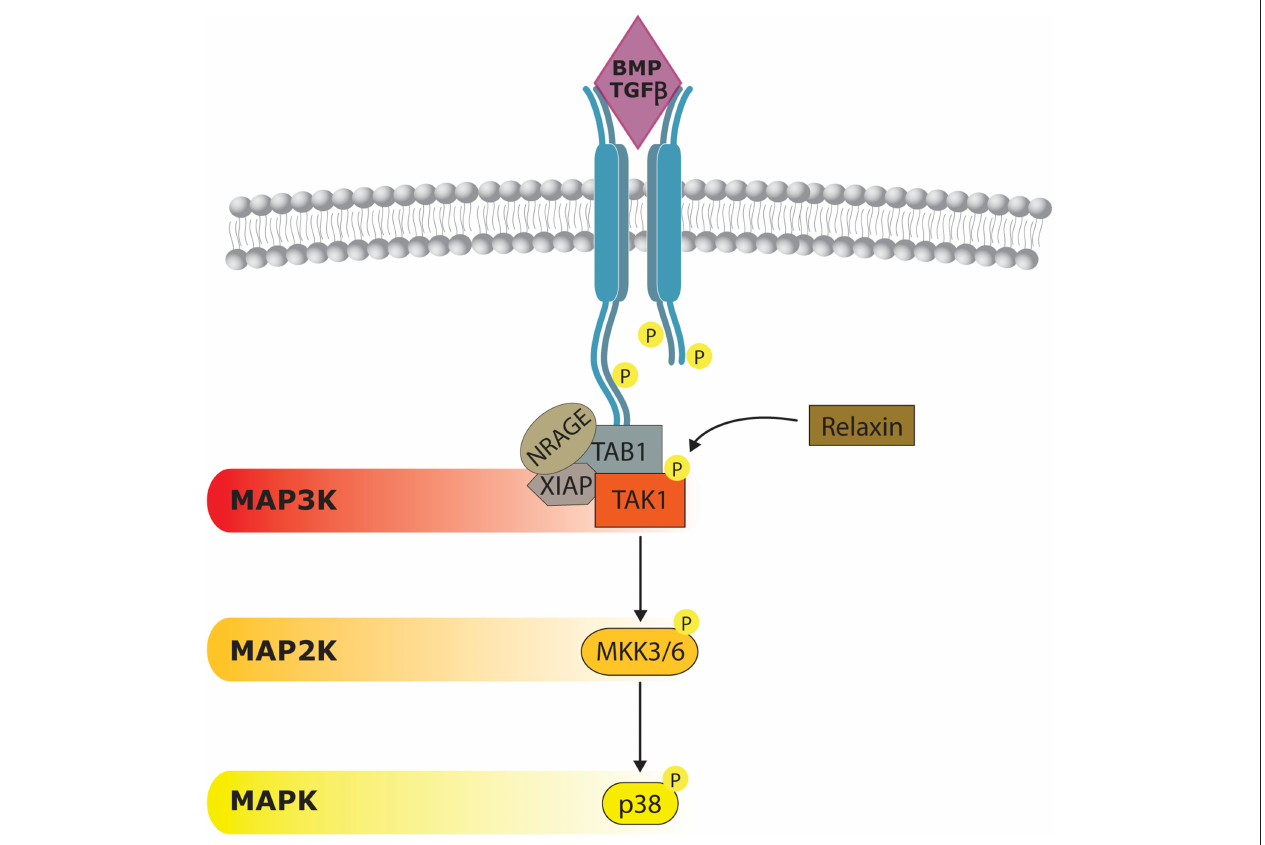
FIGURE 3 | Non-canonical BMP/TGF β signaling. p38 activity can be triggered by a BMP-dependent mechanism. Once BMP receptors (BMPR) are stimulated they form a complex formed by NRAGE, XIAP, and TAB1, which is responsible of TAK1 activation. Relaxin can act on TAK1, cooperating on p38 activation. Although considered to be independent from SMAD activity, some cross-regulation have also been